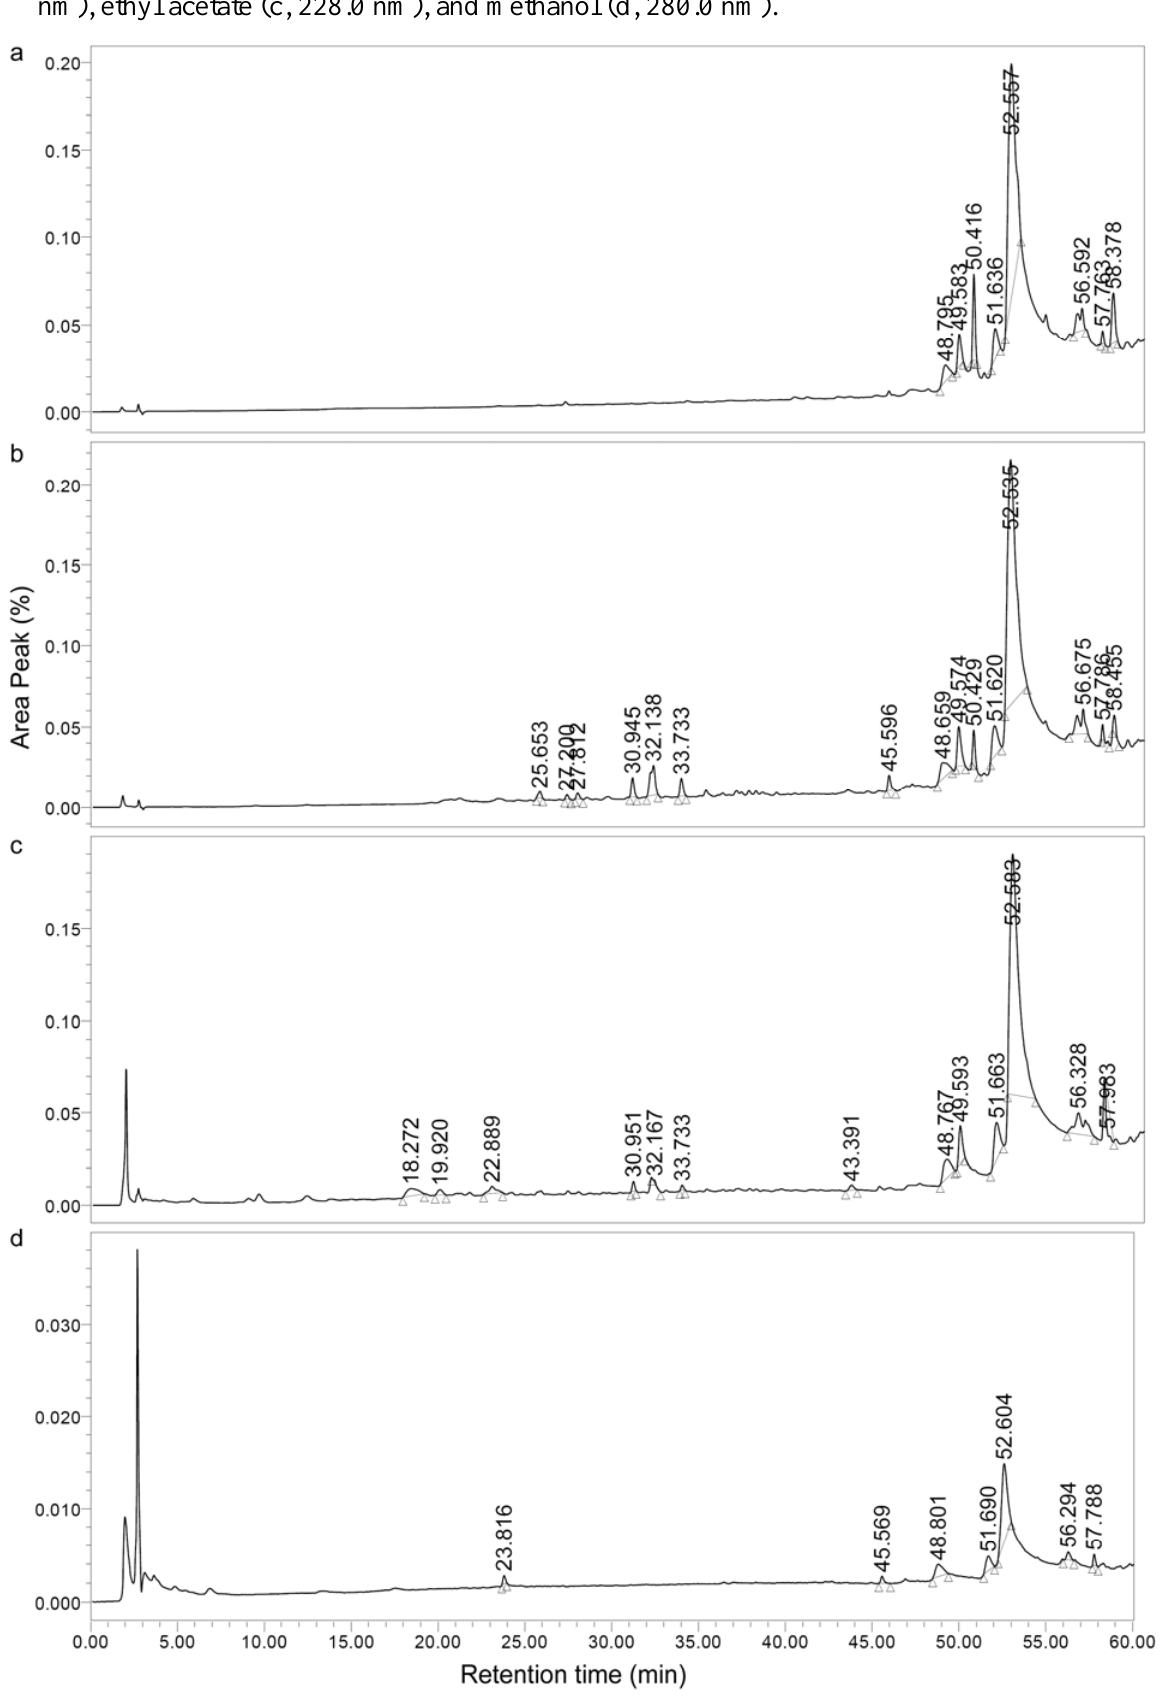
Figure 1. HPLC profiles of plant extracts in hexane (a, 228.0 nm), chloroform (b, 228.0 nm), ethyl acetate (c, 228.0 nm), and methanol (d, 280.0